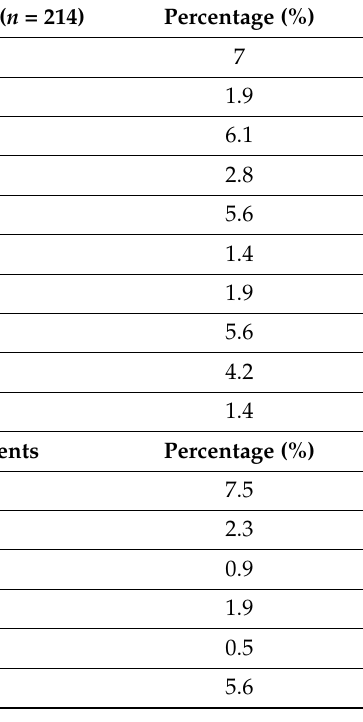
Table 4. Postoperative